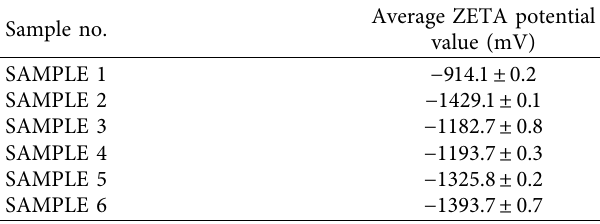
Table 9: Average ZETA potential of cement slurry formula. Sample